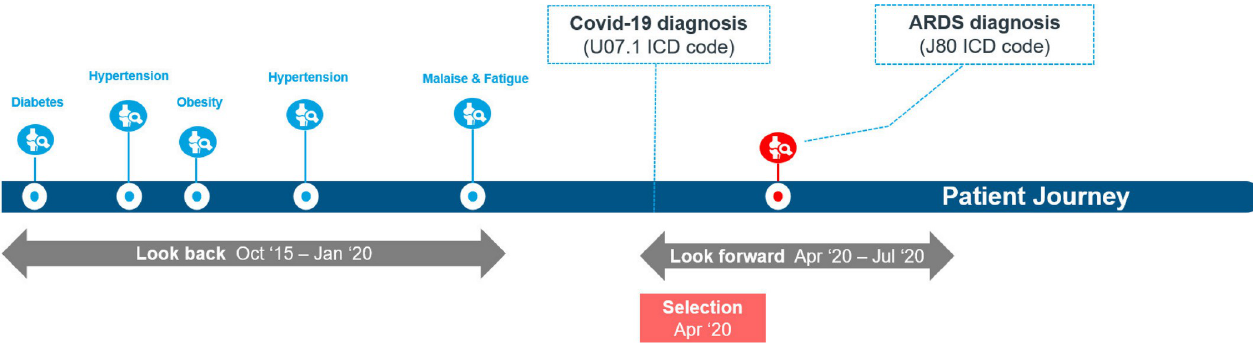
Fig 2. Overview of the cohort definition process. The modelling cohort includes patients diagnosed for the first time with COVID-19 in April 2020. If ARDS is diagnosed by July 2020, the patient is considered a severe case, otherwise non-severe. The period from October 2015 to January 2020 is used to collect diagnosis information for each patient and build the feature